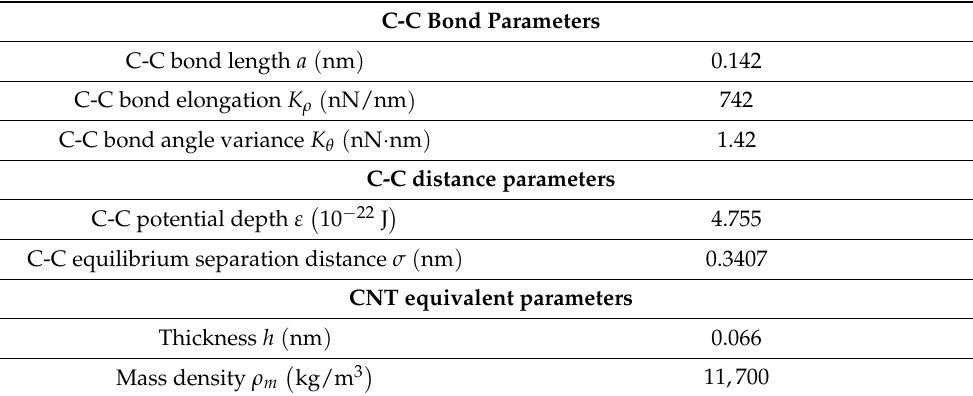
Table 1. Mechanical parameters adopted in the anisotropic elastic shell model.